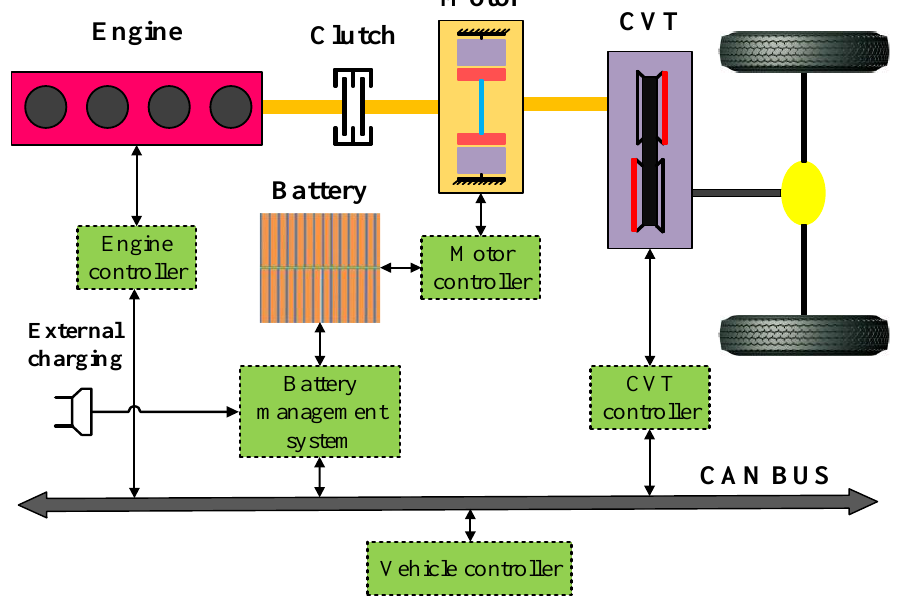
Figure 1. Structure of the vehicle transmission system.